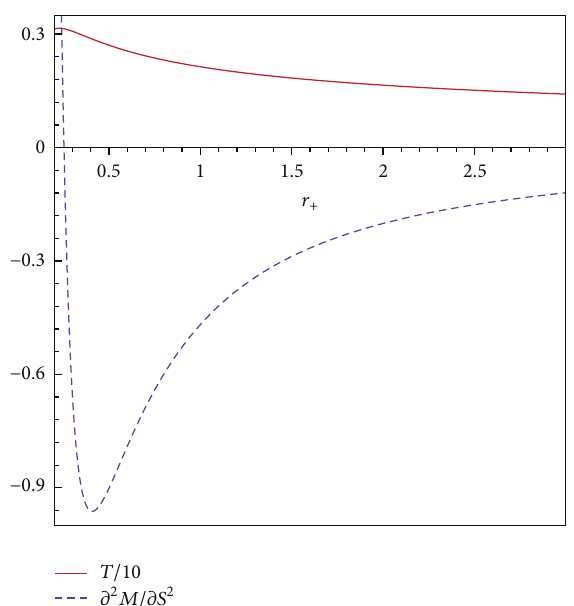
Figure 9: The behaviors of 10 −1 𝑇 and (𝜕 2 𝑀/𝜕𝑆 2 ) 𝑄, J versus 𝑟 + with 𝑙 = 1